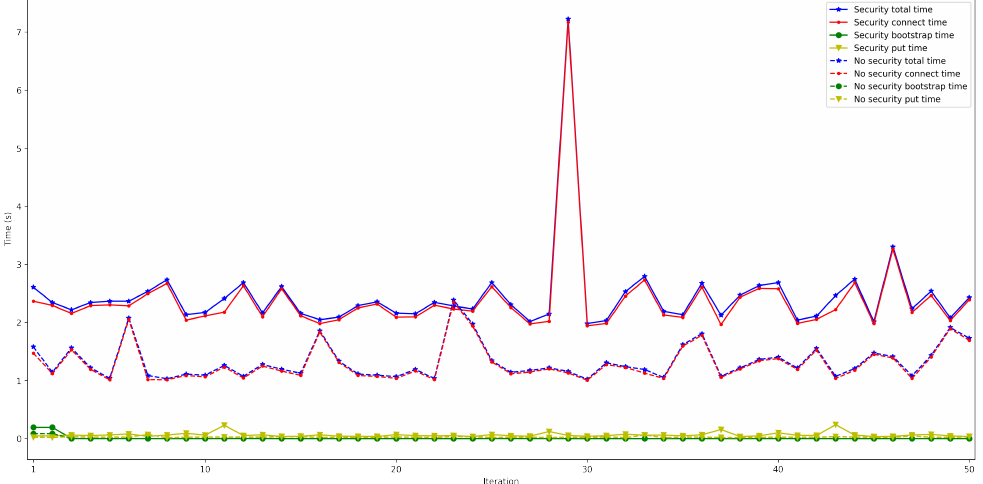
Figure 23. Latency when enabling/disabling TLS 1.3 for 100 peers connected to the bootstrap node.